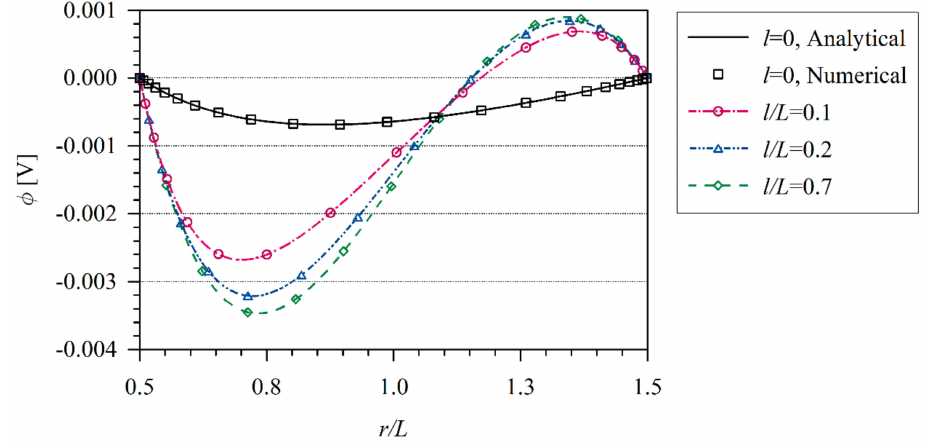
Figure 8. Electric potential variation along non dimensional x / L coordinate in hollow